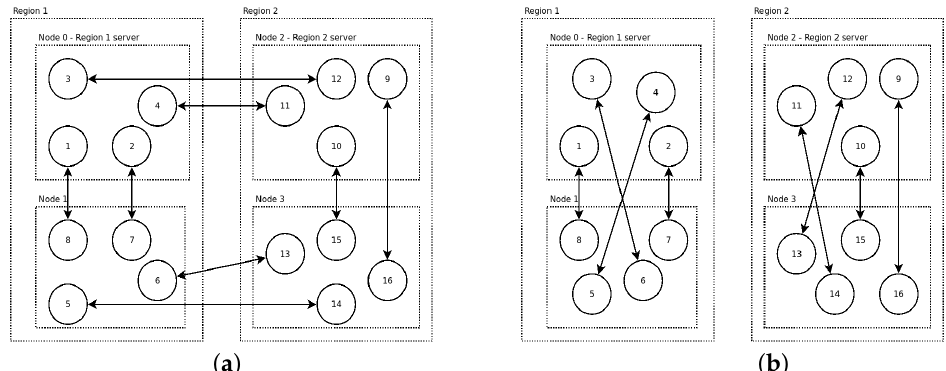
Figure 6. Communication patterns in the “intensive communication” scenario for the normal version ( a ) and the “isolated” version ( b ). Each pair of agents exchanges 200 messages. Note that although the arrows are direct between agents, messages pass through region servers.